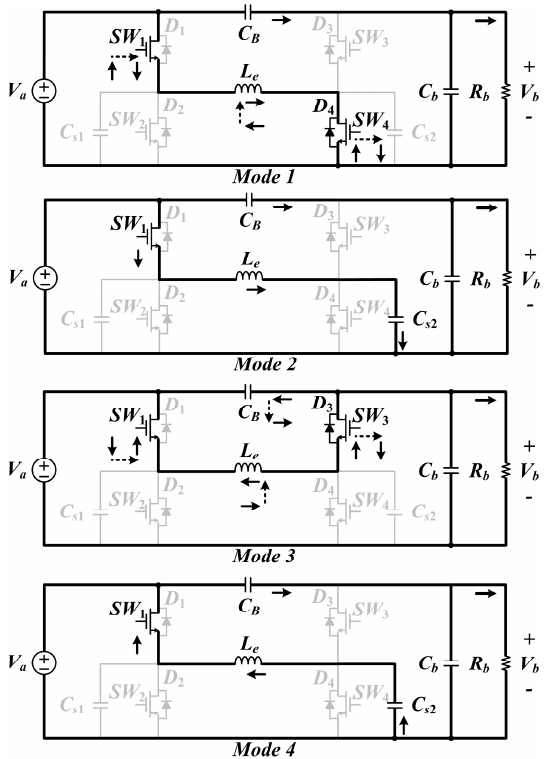
Figure 7. Circuit diagrams for the modes of operation for boost forward-conversion.